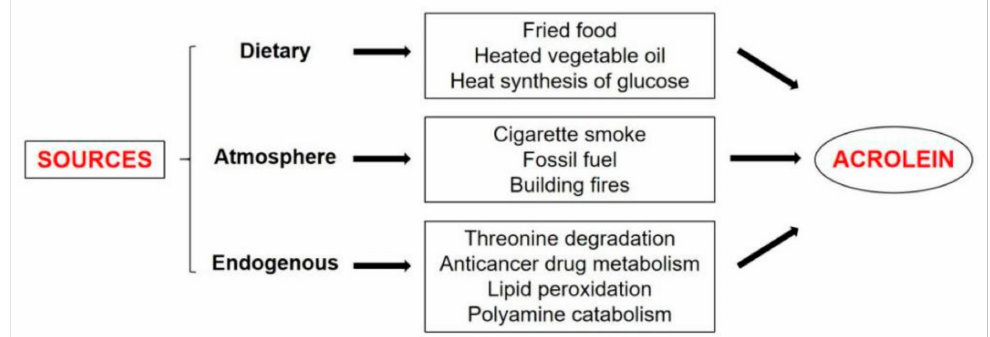
Figure 1. The sources of